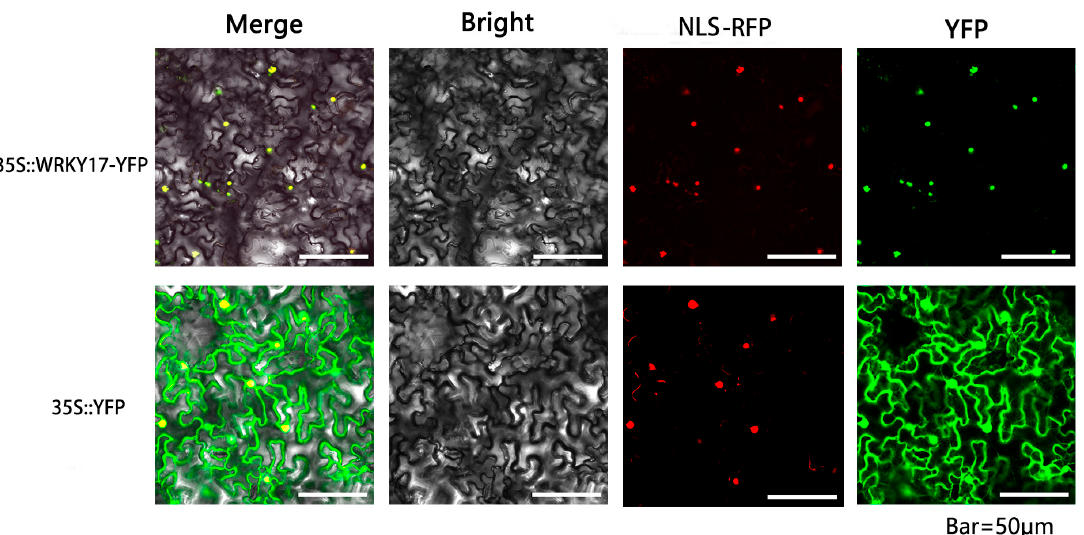
Figure 2. Subcellular localization of MfWRKY17. The constructs 35S::YFP and 35S::WRKY17-YFP were co-expressed with the nucleus marker NLS-RFP in N. benthamiana via Agrobacterium -mediated infiltration. YFP, yellow fluorescence protein; RFP, red fluorescence protein.